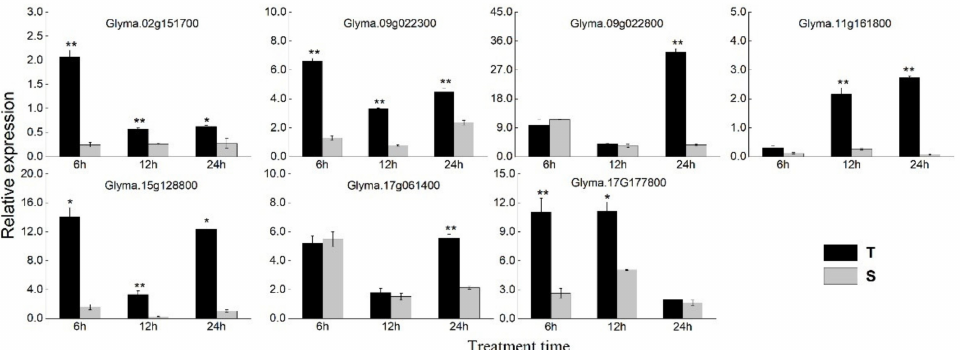
Figure 3. Expression of seven POD genes in the roots of two soybean varieties T and S in response to Al stress. The relative expression of seven POD genes in soybean root tips (0–1 cm) in response to Al stress (25 µ M AlCl 3 ) was quantified by qRT-PCR, using the soybean GmEF-1 α gene as the internal control and 0 µ M AlCl 3 (control) as reference. Means and standard deviations were calculated from three replicates. * and ** indicates significant difference (student’s t -test) in the relative expression level in response to Al stress between T and S for each time point at a significance level of 0.05 and 0.01, respectively.